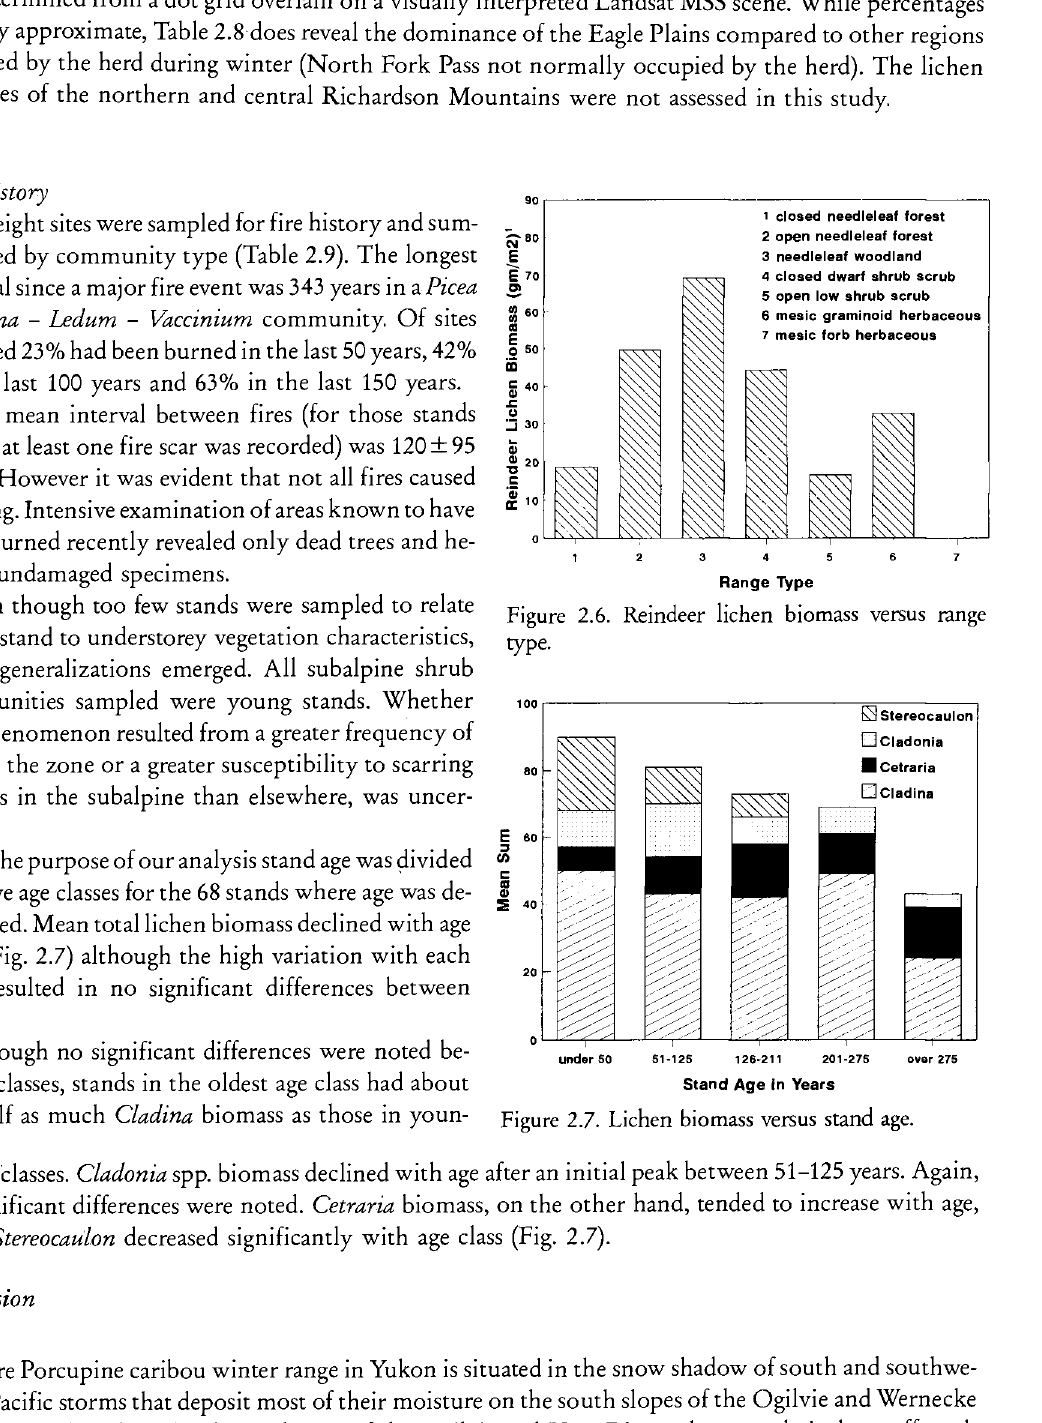
Figure 2.7. Lichen biomass versus stand